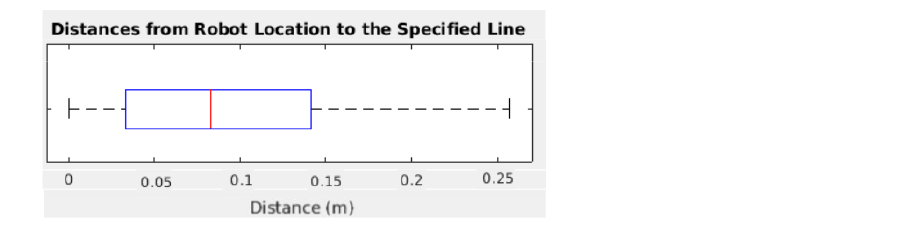
Figure 23. Box plot representing the deviation distance in meters of the robot with respect to the desired path joining the two door nodes.